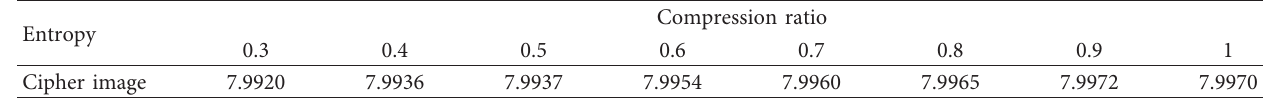
The table lists the cipher text entropies under the in- fluence of salt-and-pepper noise and Gaussian noise with different parameters. It shows that the entropy value of the achieve effective encryption.